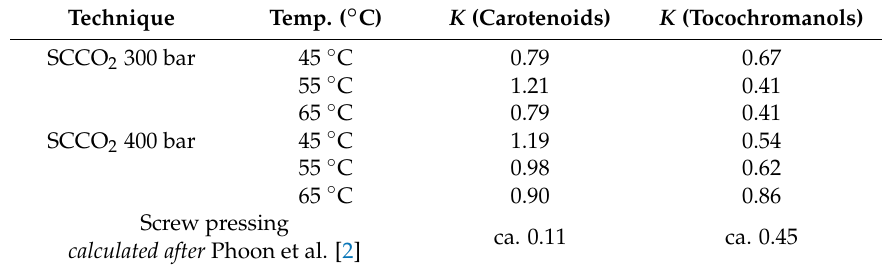
Figure 6. Concentration of carotenoids and tocochromanols in extracted and residue oils by SCCO 2 extraction at 400 bar, 55 °C, 35 kg h −1 kg −1 . Table 1. Enrichment factors of tocochromanols and carotenoids with different extraction techniques. Technique Temp. ( ◦